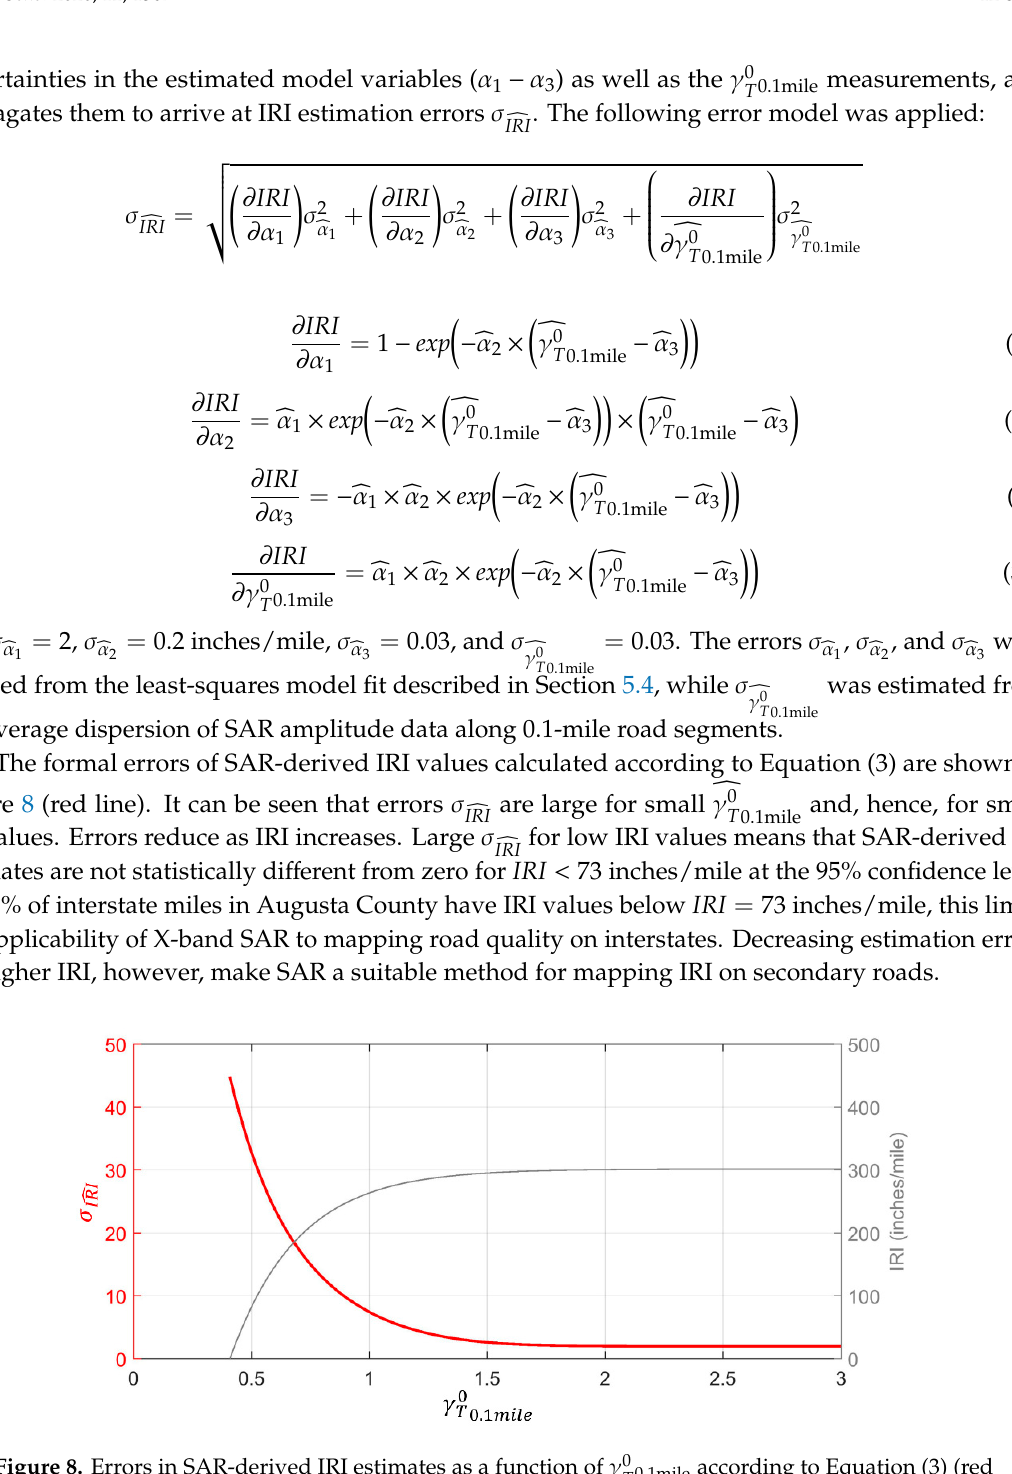
according to Equation (3) (red T 0.1mile (cid:2868).(cid:2869)(cid:3040)(cid:3036)(cid:3039)(cid:3032) as described by Equation (1) is also shown (gray line).